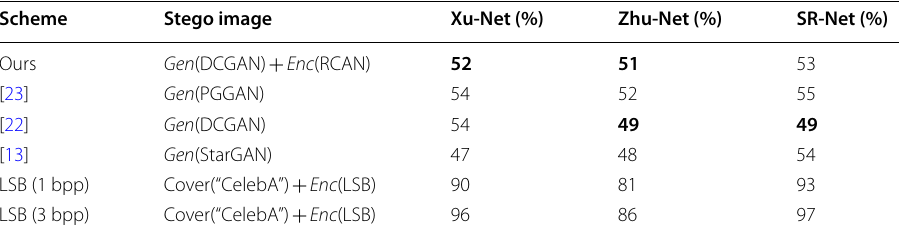
Bold values represent the best data in the comparison term